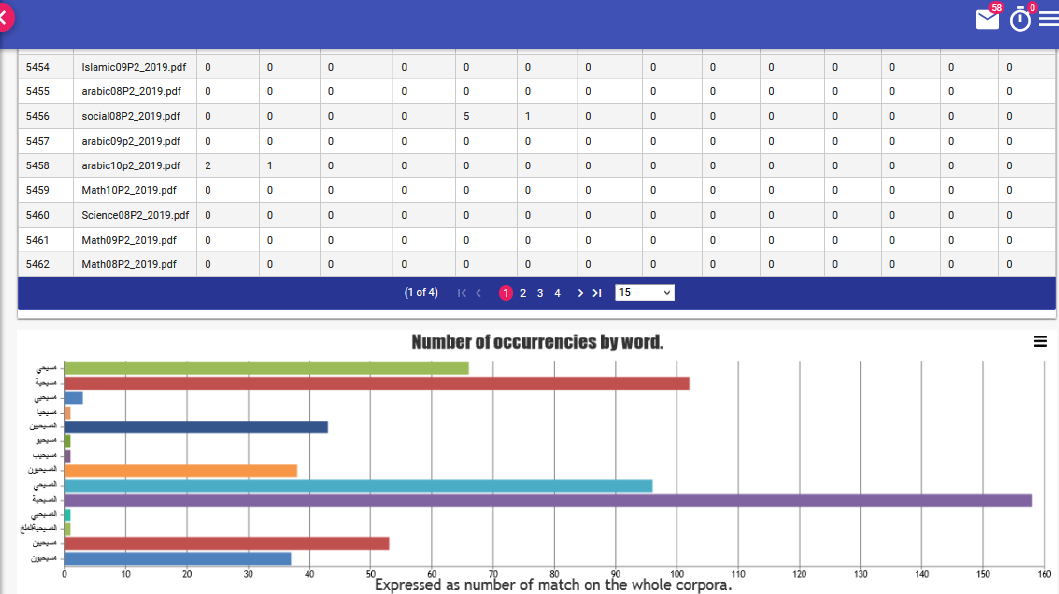
Figure 7. Graph displaying the occurrences of the word “Christian” or “ﻲﺤﻴﺴﻣ” (mas ī ḥ ī ) in each subject.